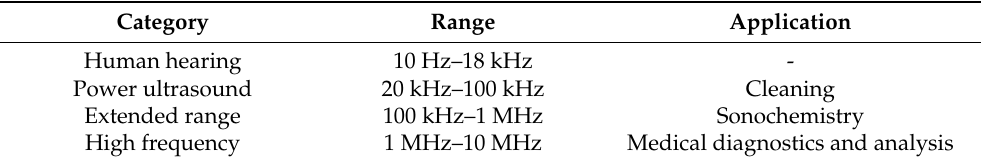
Medical diagnostics and